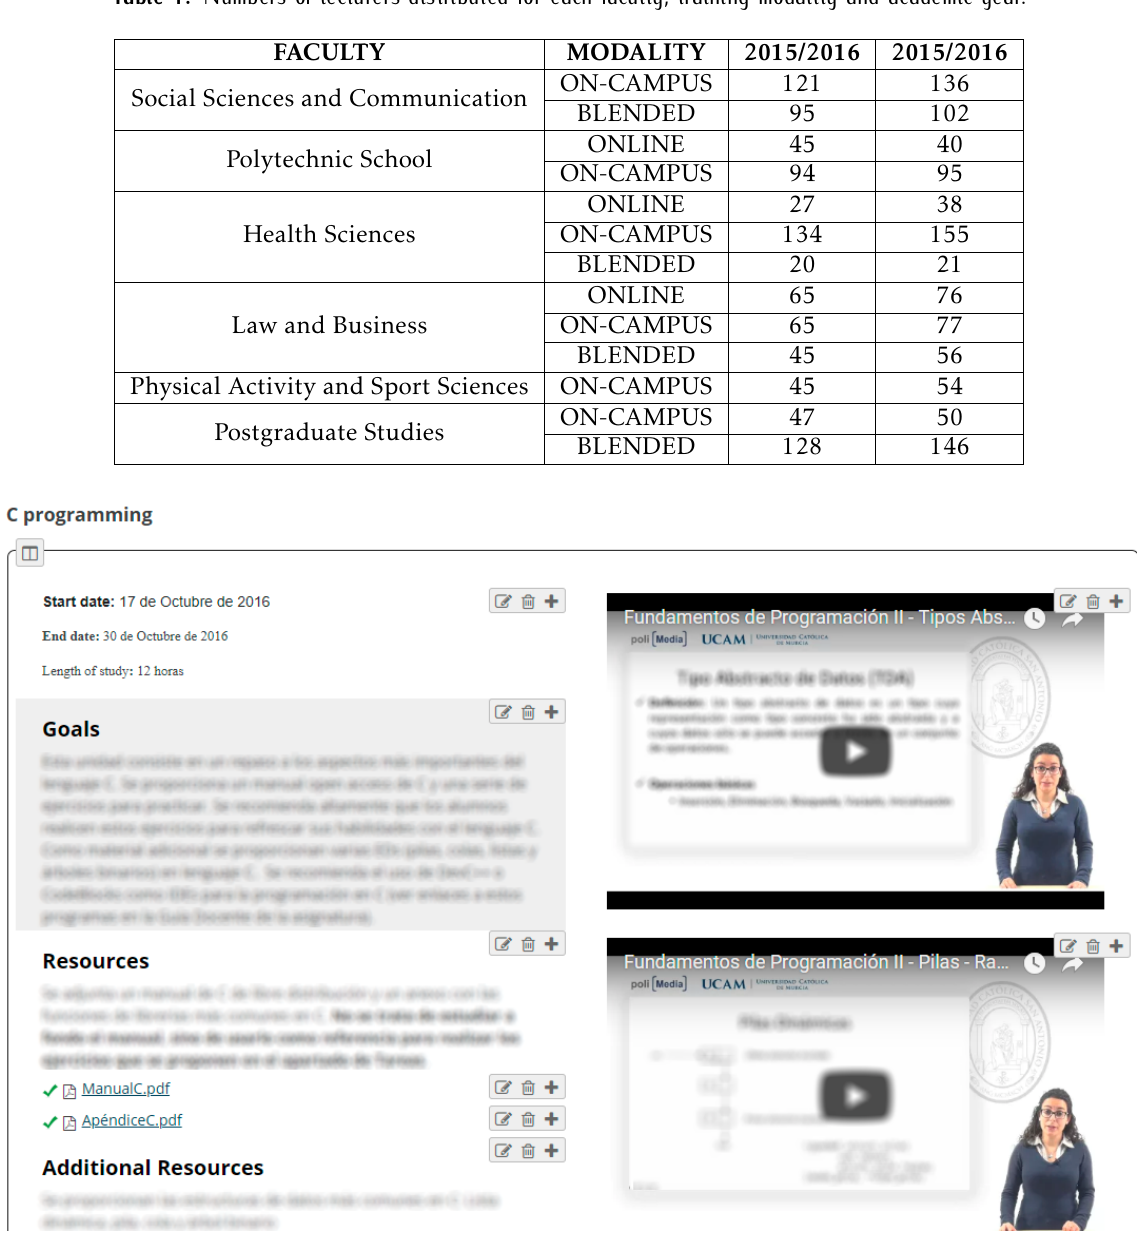
Table 1. Numbers of lecturers distributed for each faculty, training modality and academic year.